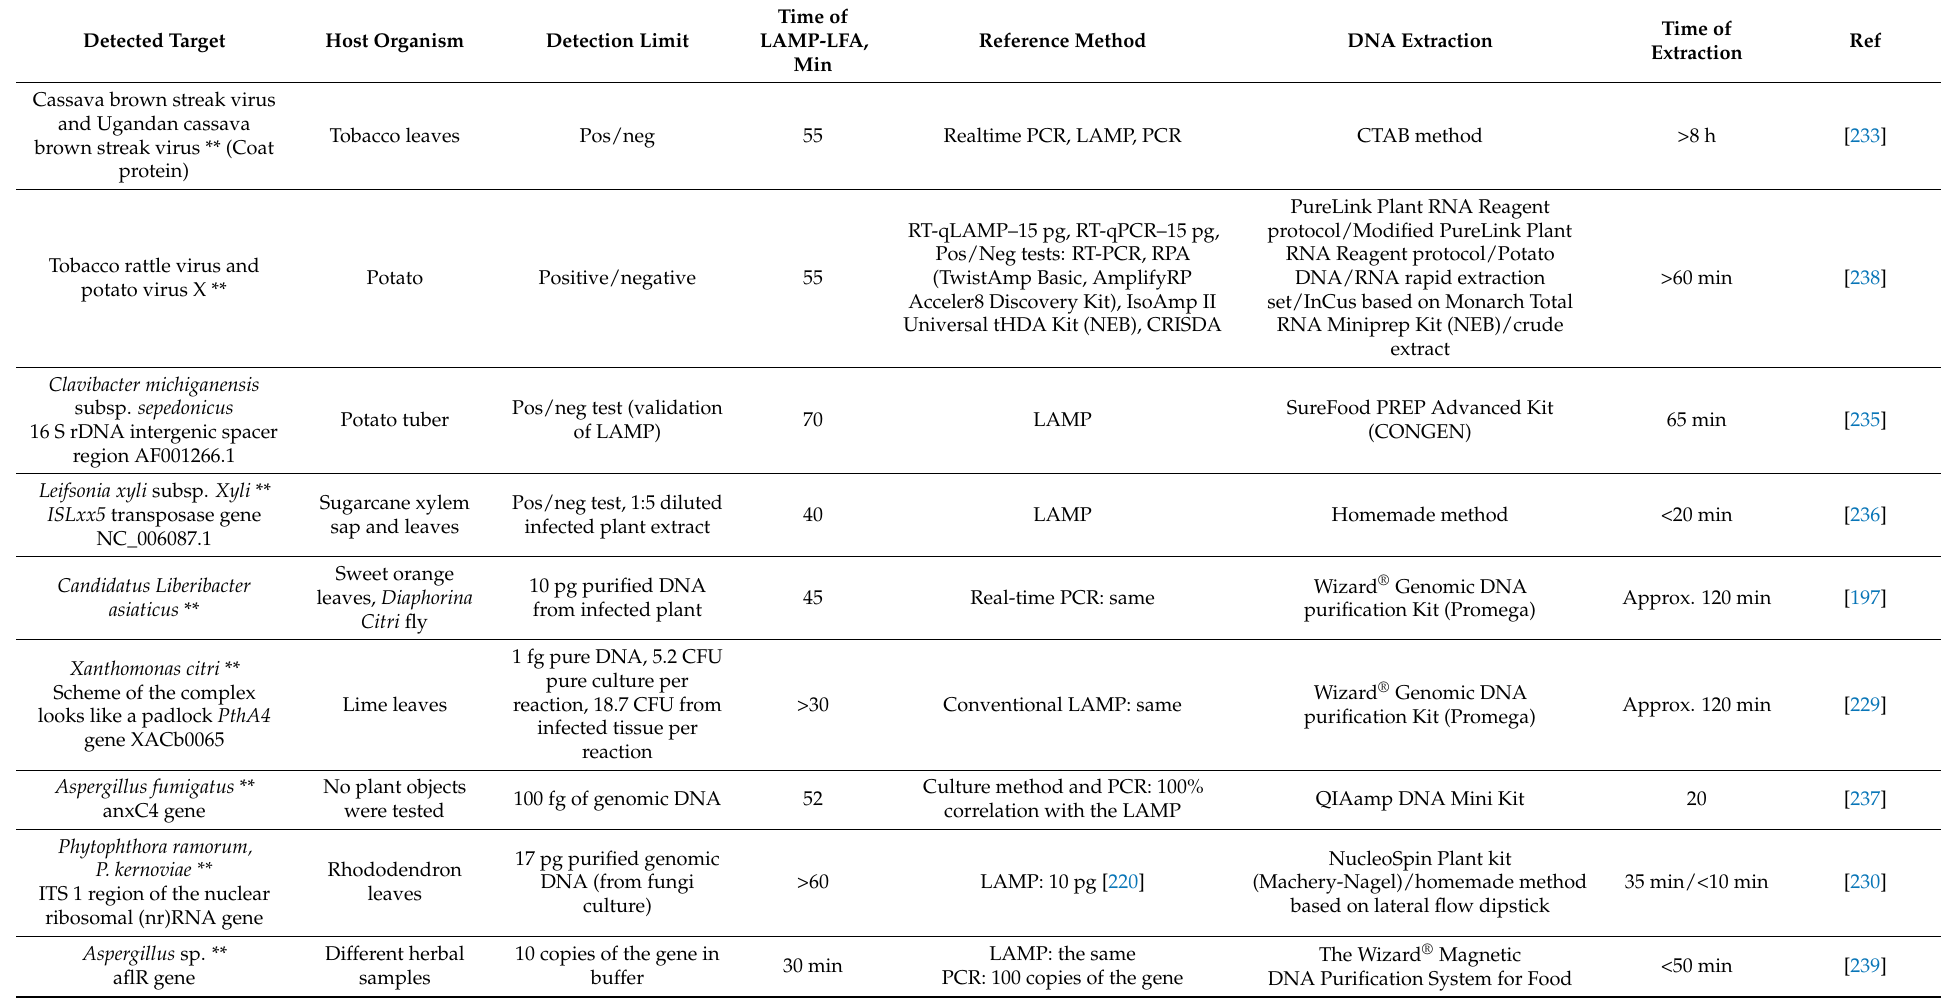
Table 2. Combination of LAMP–LFA methods for plant pathogen